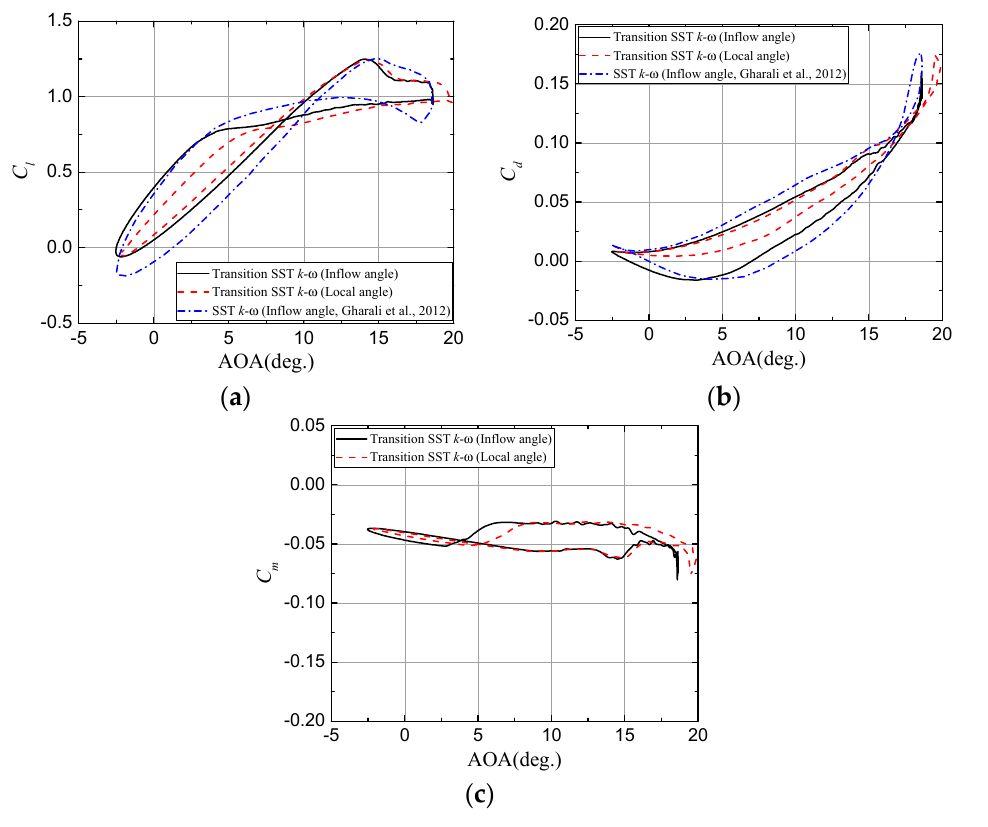
Figure 10. Comparison of aerodynamic coefficients under oscillating freestream. α m = 8°, A = 10° and k = 0.026. ( a ) The lift coefficient; ( b ) The drag coefficient; ( c ) The pitching moment coefficient.